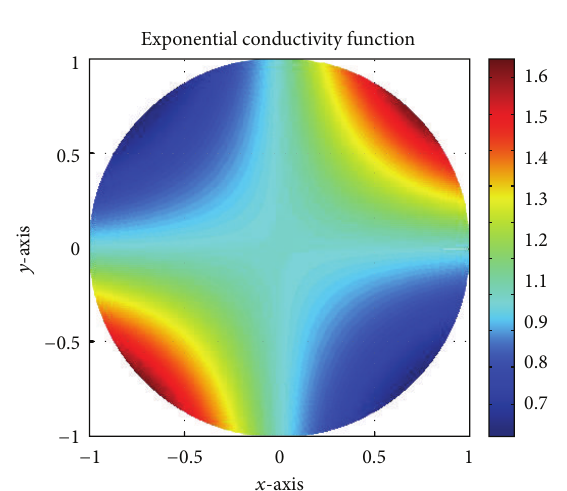
Figure4:Exampleofnonseparable-variablesLorentzianconductiv- −1 ity function 𝜎 = ((𝑥 + 𝑦) 2 + 1)